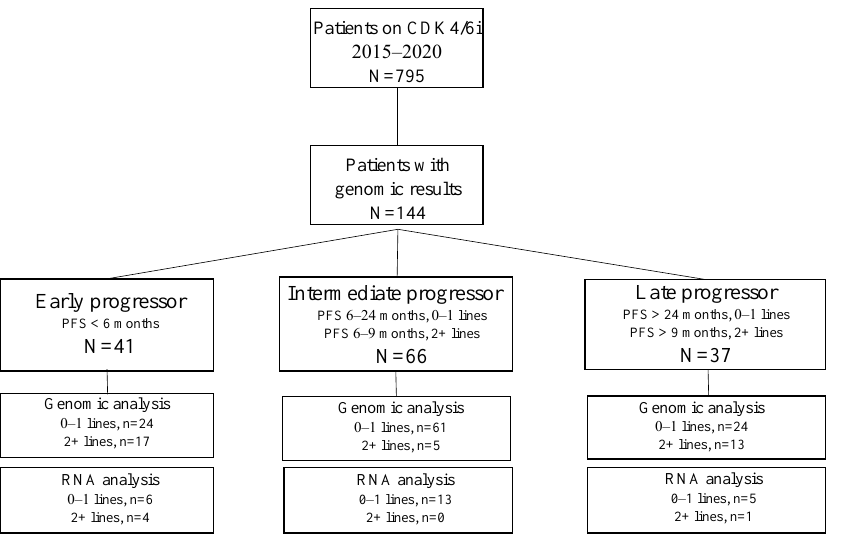
Figure 1. Flow chart showing patients included in the study and the availability of NGS and RNAseq results. Patients are grouped by PFS: Early progressors (PFS < 6 months; N = 41), intermediate progressors (PFS 6–24 months for 0–1 line; 6–9 months for 2+ lines; N = 66), and late progressors (PFS > 24 months for 0–1 line; >9 months for 2+ lines; N = 37). Of 144 patients with NGS results, 29 patients underwent Tempus testing and had RNA seq data available (N = 24 patients with 0–1 line were used for differential gene